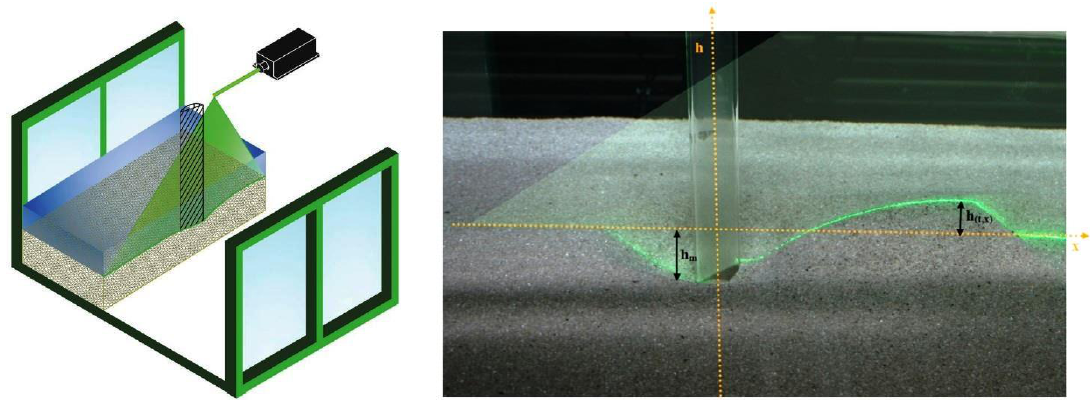
Figure 2. Schematic representation of the new technology.